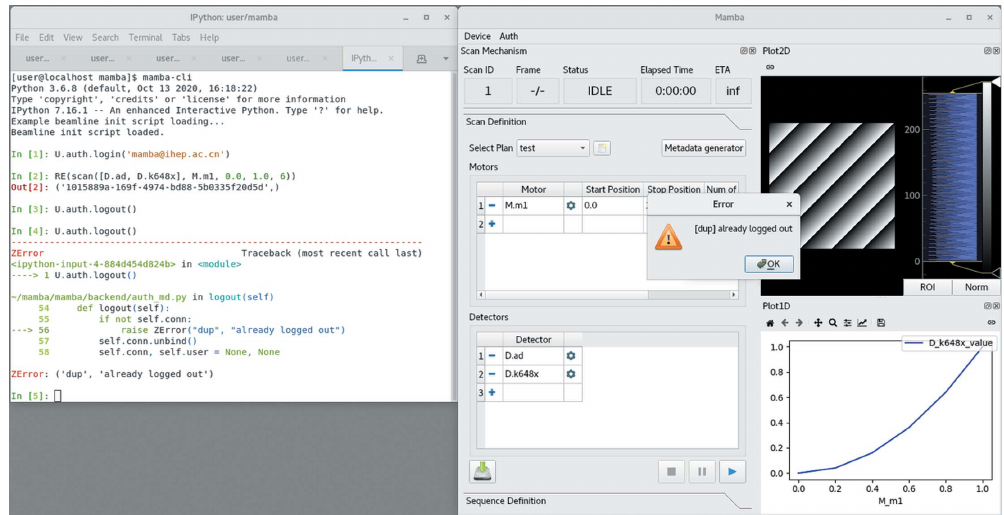
Figure 1 Command injection in Mamba , showing an error caused by attempting to log out twice after a successful experiment session; we explicitly note that the appearance of the GUIs may vary in the future due to ongoing frontend